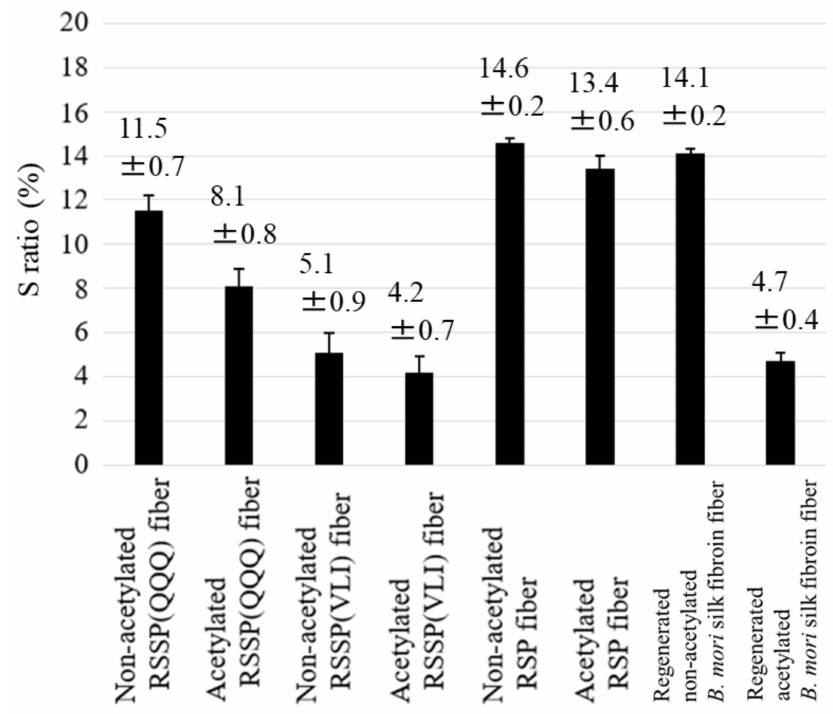
Figure 7. The secondary contraction, S ratio, of eight kinds of silk fiber, i.e., non‑acetylated and acetylated fibers of RSSP(QQQ), RSSP(VLI), RSP, and regenerated B. mori silk. The S ratio is defined in the